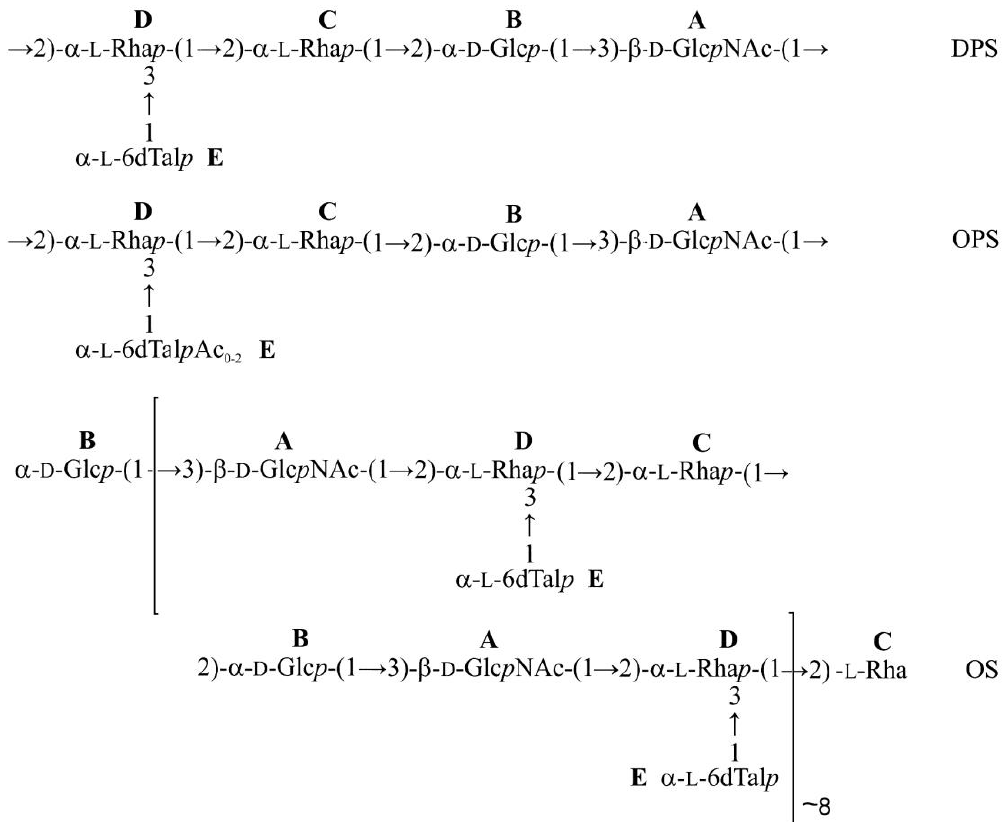
Figure 9. Structures of the O-deacetylated polysaccharide (DPS) (top), O-polysaccharide (OPS) (middle) from Pectobacterium carotovorum strain F160, and the oligosaccharide derived by depolymerization of the O-polysaccharide by tail spike protein gp41 (OS) (bottom). Int. J. Mol. Sci. 2019 , 20 , x FOR PEER REVIEW